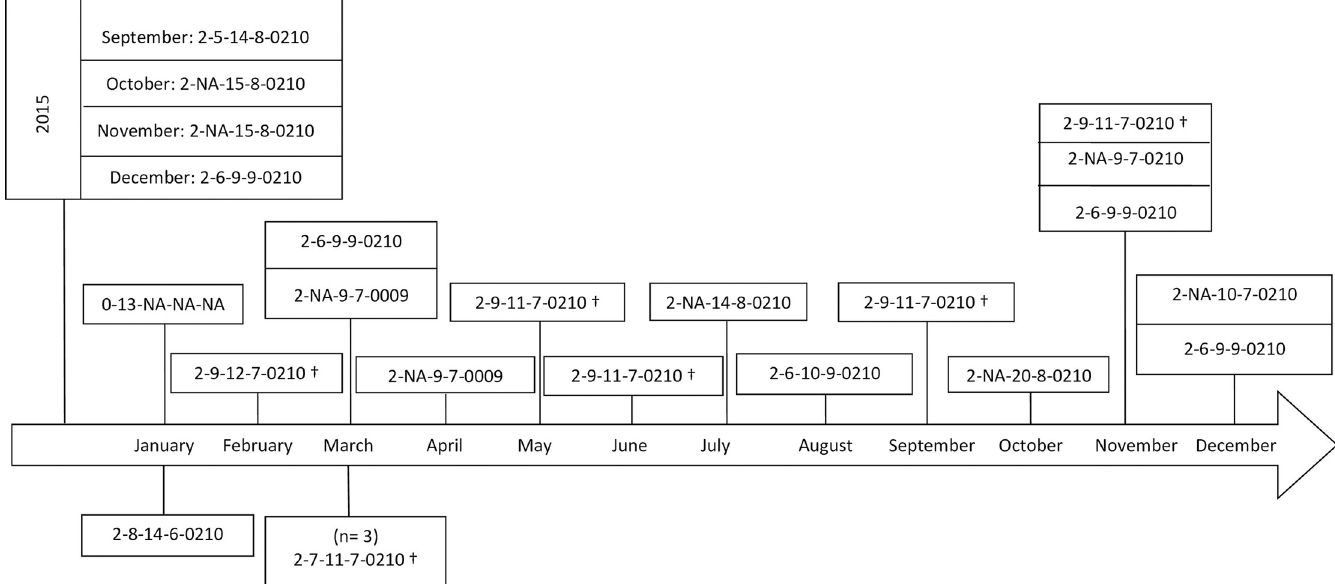
Fig 2. Multi-locus variable-number tandem repeat analysis (MLVA) of 19 Salmonella Typhimurium invasive isolates (blood cultures, above the timeline) versus four Salmonella Typhimurium intestinal isolates (stool culture, below the timeline). Position of the isolates along the timeline represents the time of isolation in 2015 or 2016. Series of 5 numbers represent 5 loci on which each number corresponds to the numbers of alleles amplified and “NA” corresponds to a locus on which no allele has been amplified. Symbol “†” denotes highly related MLVA types among intestinal and invasive isolates.